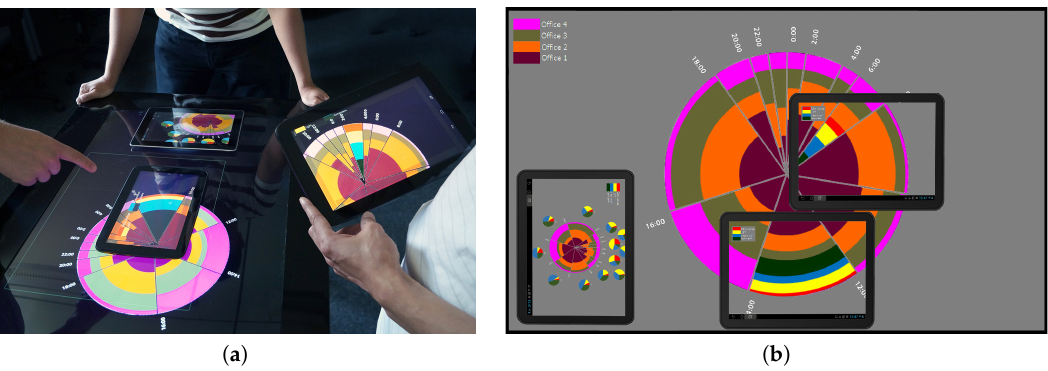
Figure 18. A co-located collaborative visualization session using Show-Me ( a ), with each tablet device showing its own view of the shared tabletop visualization ( b ). Images from Reference